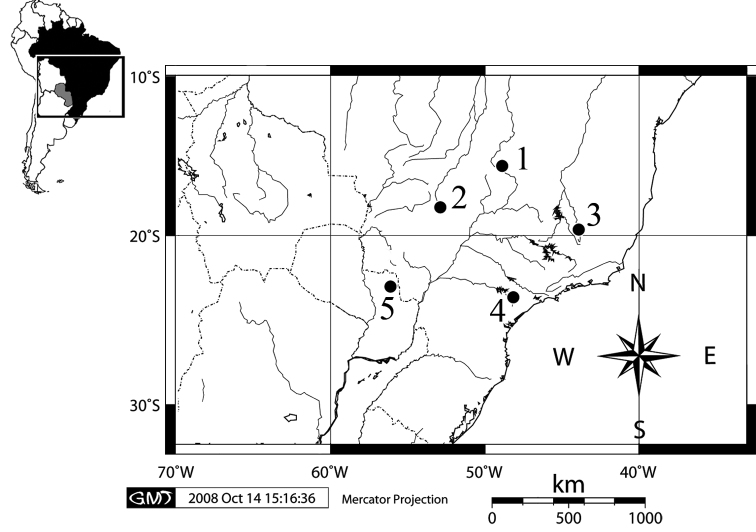
Map of karyotyped populations showing the type localities of Clyomys laticeps and its synonyms: Brazil, Distrito Federal, Brasília [1] (Svartman 1989); Goiás state, Mineiros, Emas National Park [2] (this study); Minas Gerais State, Lagoa Santa [3] (type locality of Clyomys laticeps – Thomas 1909); São Paulo state, Itapetininga [4] (Yonenaga 1975, Souza and Yonenaga 1984; also type locality of Clyomys bishopi – Avila-Pires and Wutke 1981); Paraguay, Departamento de San Pedro, Partido de Tacuatí, Acai-Poi [5] (type locality of Clyomys laticeps whartoni – Moojen 1952). Small map of the South America show the Brazil in black colour and the Paraguay in gray.